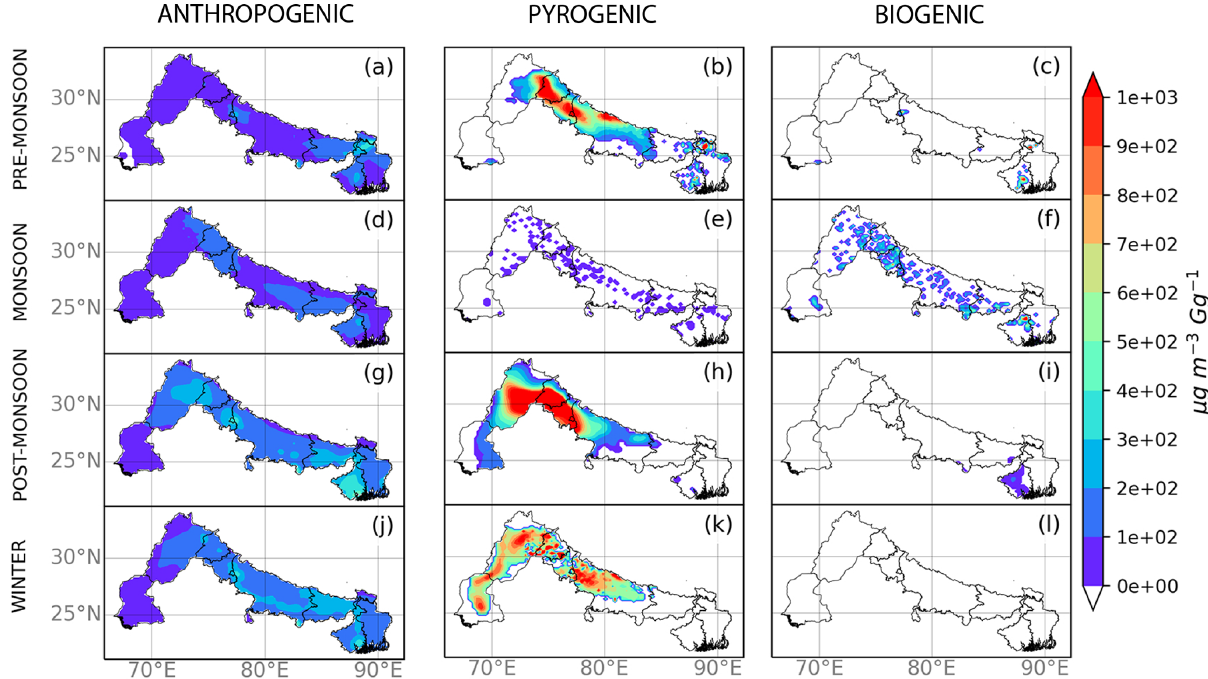
Figure 4. Seasonal sensitivity of PM 2 . 5 concentrations to changes in (a, d, g, j) anthropogenic, (b, e, h, k) pyrogenic, and (c, f, i, l) biogenic emissions (µgm − 3 Gg − 1 ). The calculation is described in the main text. Regions marked in white denote where sensitivity corresponds to PM 2 . 5 concentrations below the set threshold of 4µgm − 3